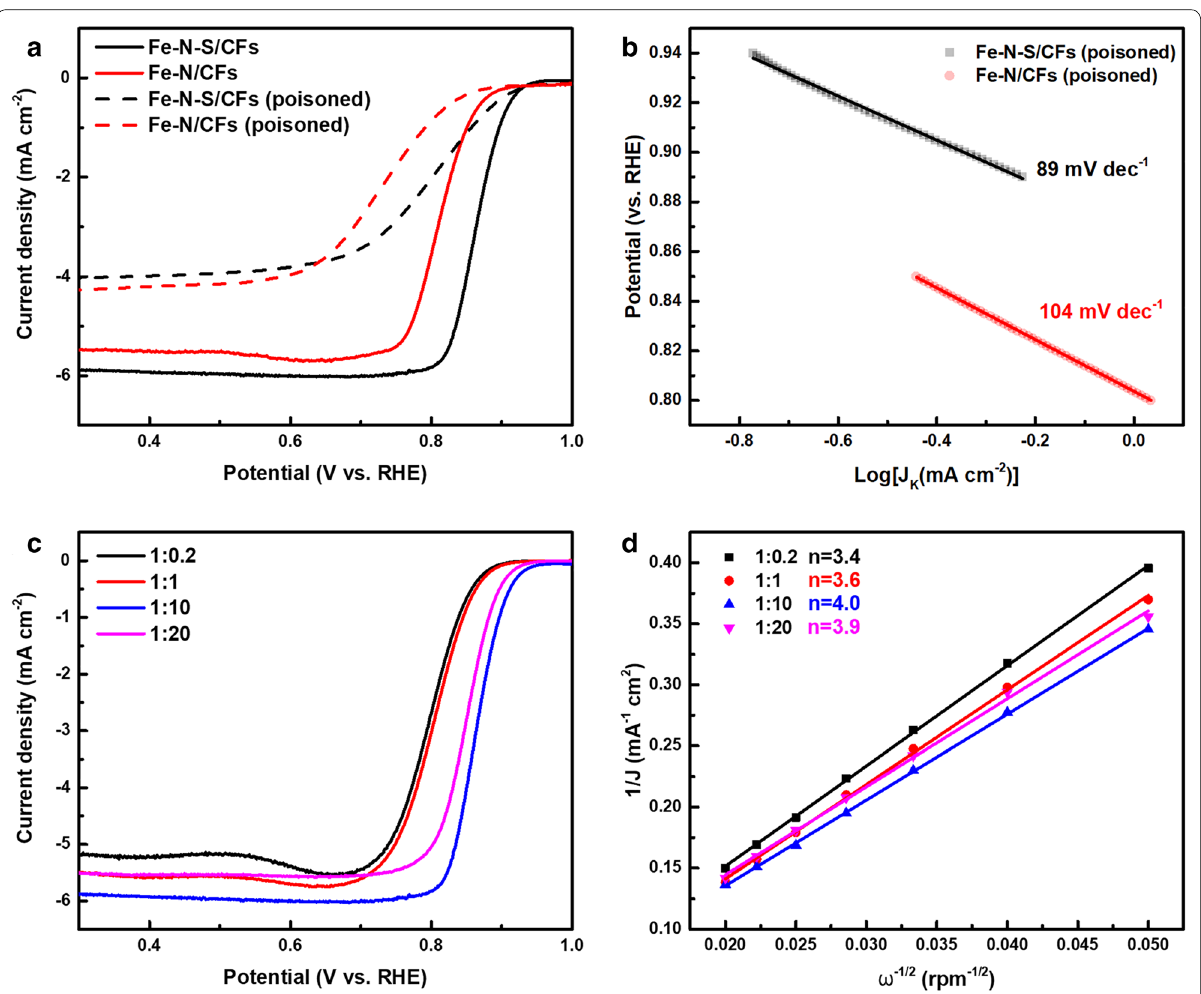
Fig. 5 a LSV curves of Fe–N–S/CFs and Fe–N/CFs before and after poisoned by SCN − tested at the rotating speed of 1600 rpm. b Tafel plots of Fe–N–S/CFs and Fe–N/CFs after poisoned by SCN − . c LSV curves of N and S codoped carbon frameworks with different doping ratio measured at the rotating speed of 1600 rpm. d K–L plots of N and S codoped carbon frameworks with different doping ratio at 0.4 V vs.